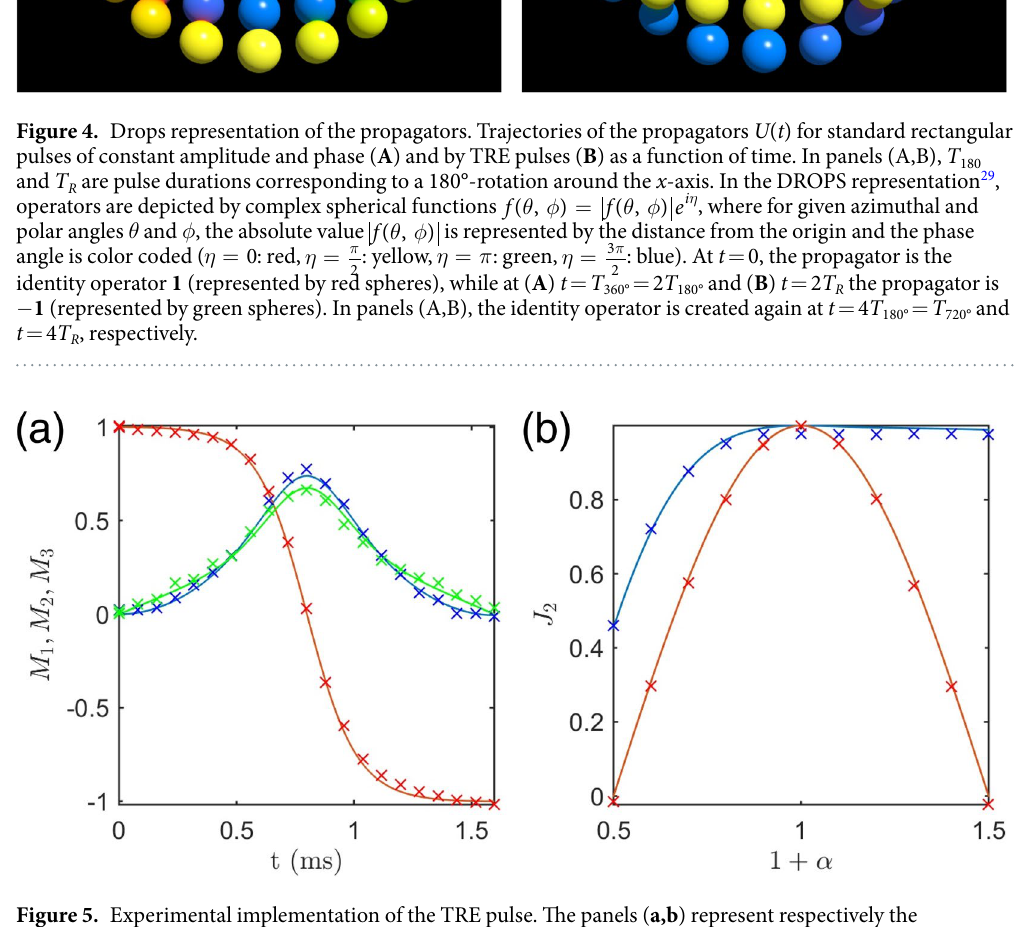
thus negligible since orders of magnitude larger than the pulse duration. The trajectory measurements were made by interrupting the control pulse at different times t . The x - and y -components of the Bloch vector were directly acquired. For the z -coordinate, the experiments were repeated with an additional π pulse along the x -direction 2 before the acquisition in order to flip the z -component of the magnetization vector to the transverse plane. The TRE pulse duration was set to 1.5965 ms and the parameters k and E to 0.7 and 0.2457, respectively. The π pulse is defined as a rectangular shaped pulse with the same amplitude and with 1000 intervals to be consistent with the digitization of the TRE pulse. The evolution of the Bloch vector and the robustness of the shaped pulse with respect to the scaling factor α are displayed in Fig. 5. For the robustness experiments, we scaled the amplitude with factors ranging from = − M α = − 0.5 to α = 0.5 in 11 steps. The figure of merit J 2 is here defined by J 2 2 ( t f ). In the experimentally meas- ured trajectories, each data point corresponds to the average of 16 scans in order to increase the signal-to-noise ratio of the experimental spectra. Small but finite sources of systematic errors 30 , in the NMR experiments are (a) relaxation losses during the pulses, (b) B 0 inhomogeneity, (c) non-linear effects due to radiation damping 31 , (d) pulse shape distortions due to the amplifiers and the finite bandwidth of the resonator 32 and (e) partial saturation